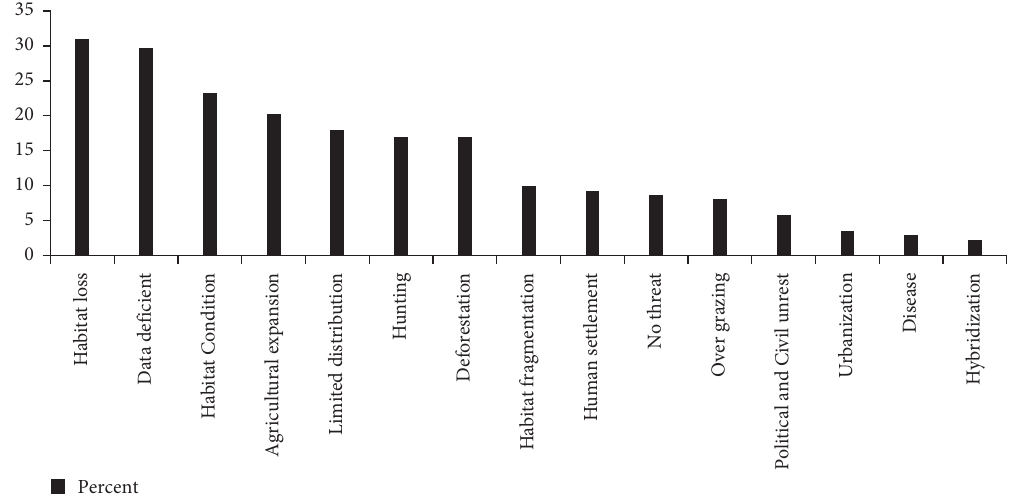
Figure 3: Ranked frequency of conservation threats that endemic mammals face across the regions of Eastern Africa.